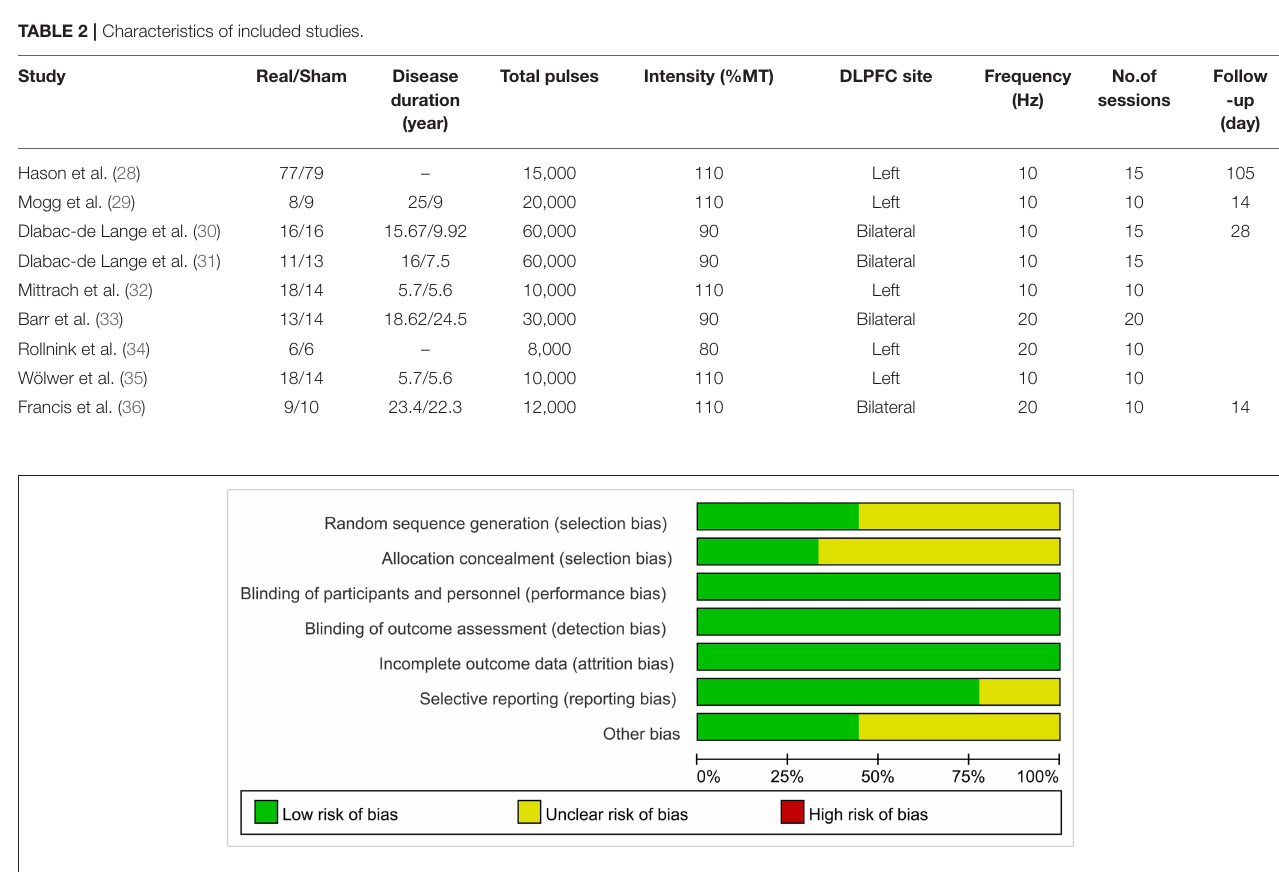
FIGURE 2 | The assessment of bias risk in the 9 studies included in the quantitative synthesis.